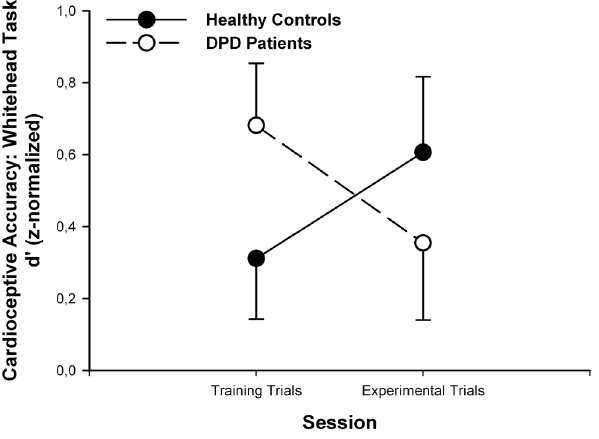
Figure 1. Change of the performance in the Whitehead task from the training to the experimental trial between the two groups. Circles indicate means and error bars correspond to standard error of mean (SEM). There were no significant within or between group differences regarding CA Whitehead . However, the two groups differed significantly regarding the direction of their changes (F(1,43)=4.359, p=0.043).